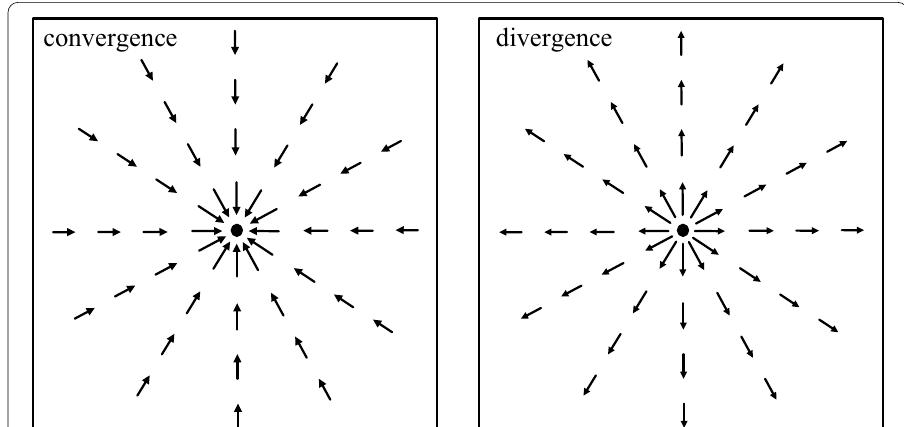
Fig. 5 Simulation diagram of ground wind field